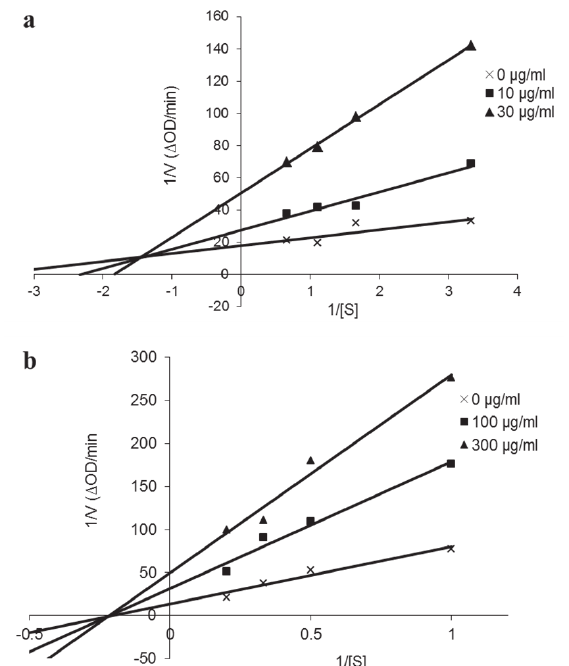
Figure 3 - Lineweaver-Burk plots of the reaction of porcine pancreas α -amylase ( a ) and yeast α -glucosidase ( b ) at different concentrations of substrate and saponin